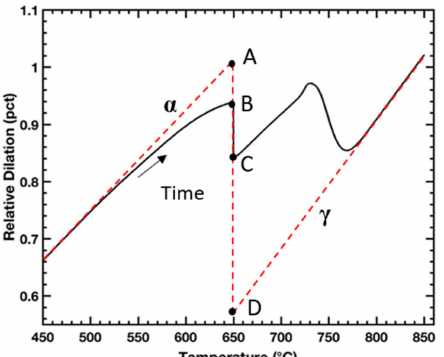
Figure1. Schematic depictingmethod for insitu austenitevolume fraction assessmentsfrom dilatometry during intercritical annealing. Overlaid on the dilation data are dashed lines that extrapolate thermal expansion of the sample corresponding to regions when the sample is fully ferritic / tempered martensite and fully austenitic labeled α and γ , respectively. The line length fraction AC / AD corresponds to austenite volume fraction formed during heating and isothermal